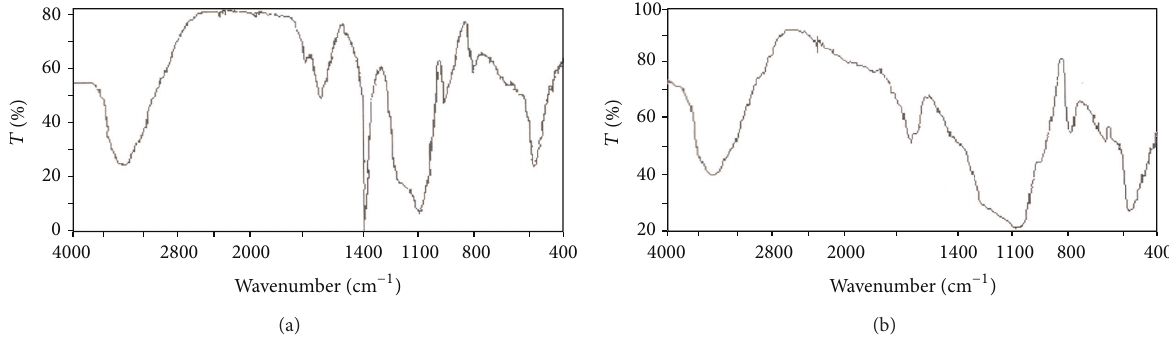
Figure 1: (a) IR-spectra of MG-Fe doped (F3M1) glass (air dried). (b) IR-spectra of MG-Fe doped (F3M1) glass (heat treated at 150 ∘